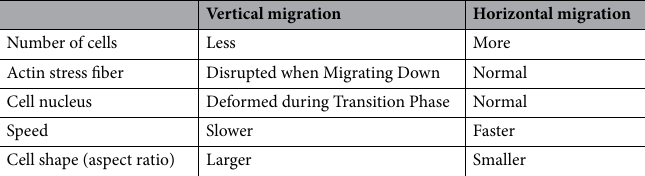
Table 1. Differences between horizontal and vertical